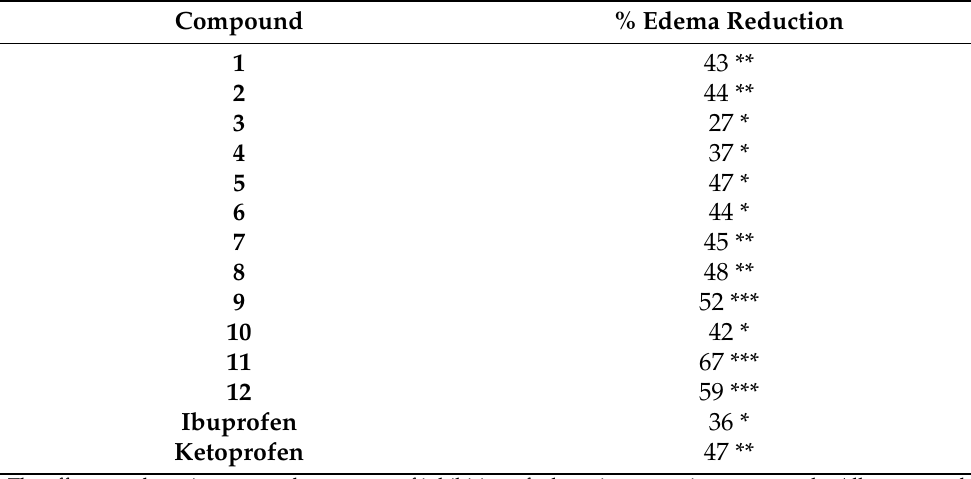
Table 3. Effect of compounds 1 – 12 , ibuprofen and ketoprofen on carrageenan-induced rat paw edema a .